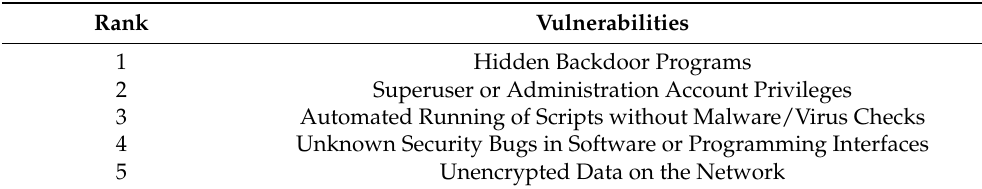
Table 1. Top five computer security vulnerabilities in 2019.